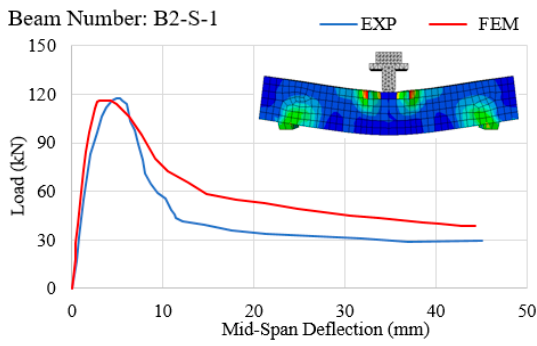
Figure 19. Load vs. mid-span deflection for B2-S-1.